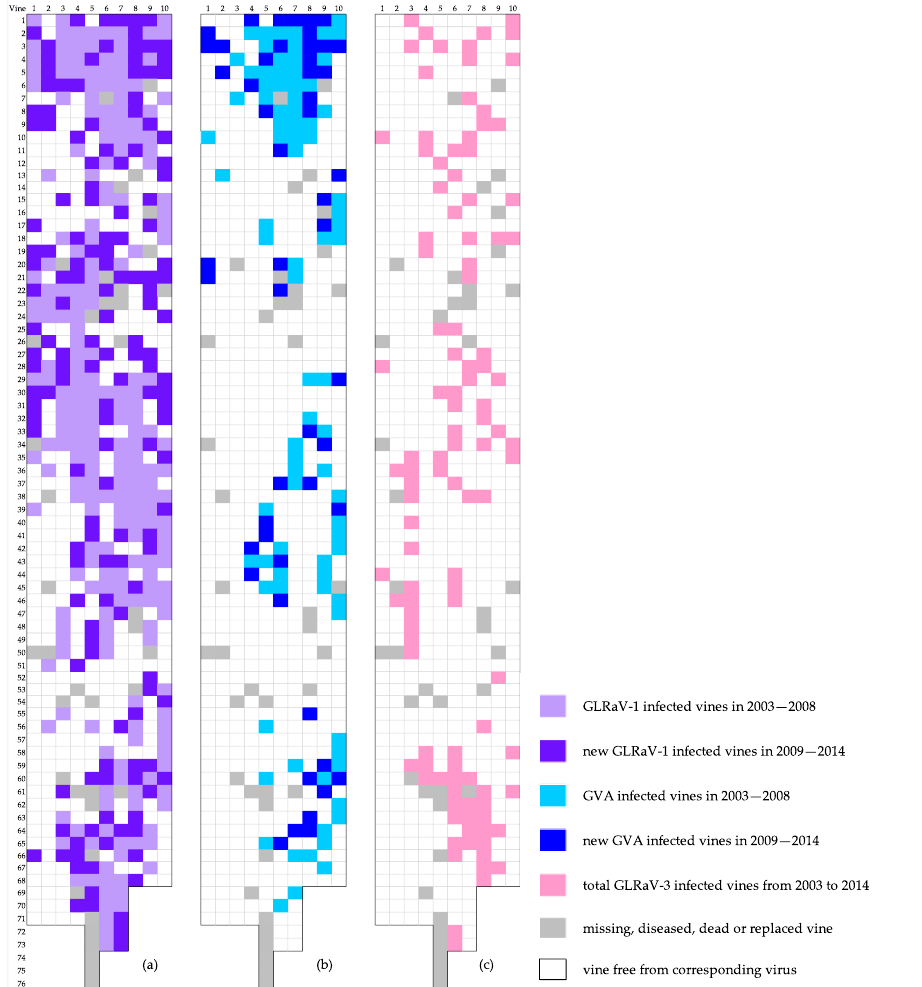
Figure 5. Evolution of the spatial distribution of grapevine leafroll-associated virus-1 (GLRaV-1) ( a ) and of grapevine virus A (GVA) ( b ), from 2003 to 2014 in the Riesling plot in Nothalten. ( c ) Spatial distribution of all GLRaV-3-infected vines over the survey period 2003 – 2014. Each square corresponds to a vine stock. The x -axis represents row numbers, whereas vine stocks within rows are numbered along the y -axis, with numbers increasing from north to south.